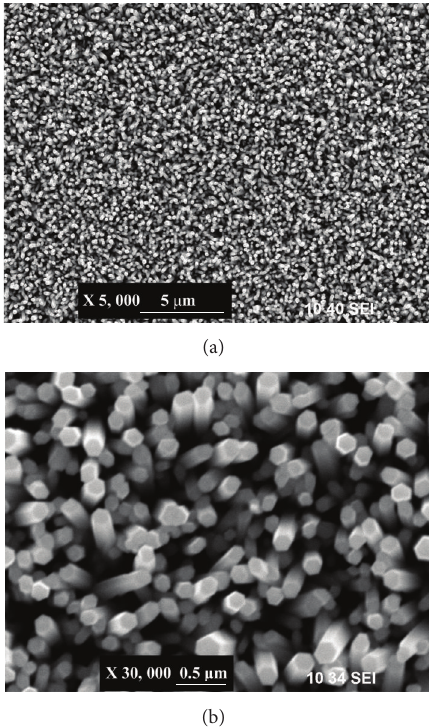
Figure 2: SEM images of ZnO nanorod arrays. (a) Large-scale and low magnification and (b) high magnification.